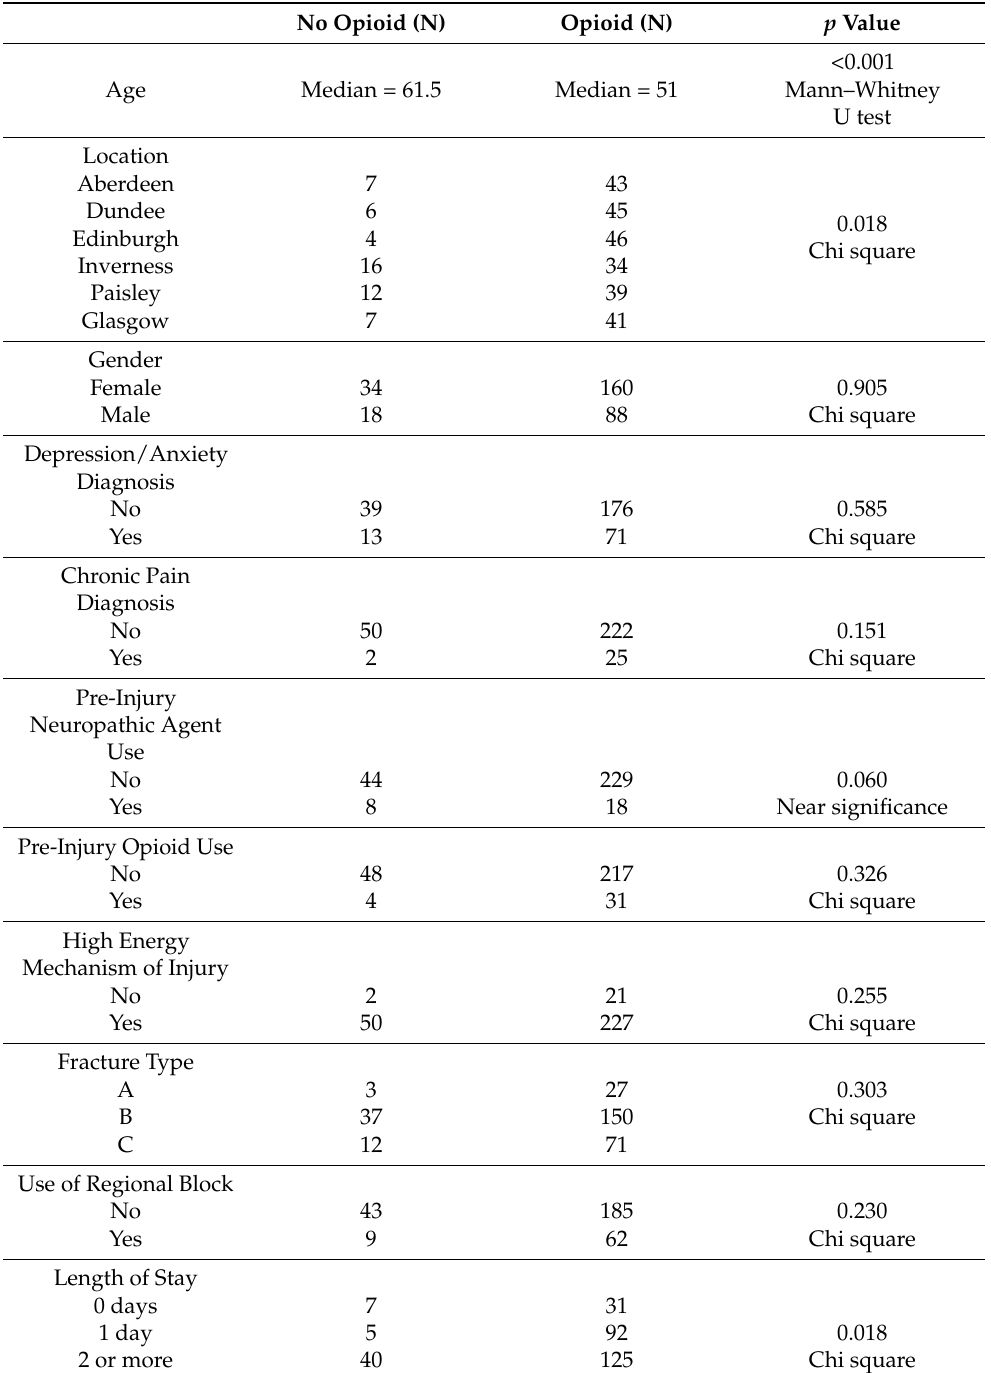
Table 6. Univariate analysis of ankle fracture